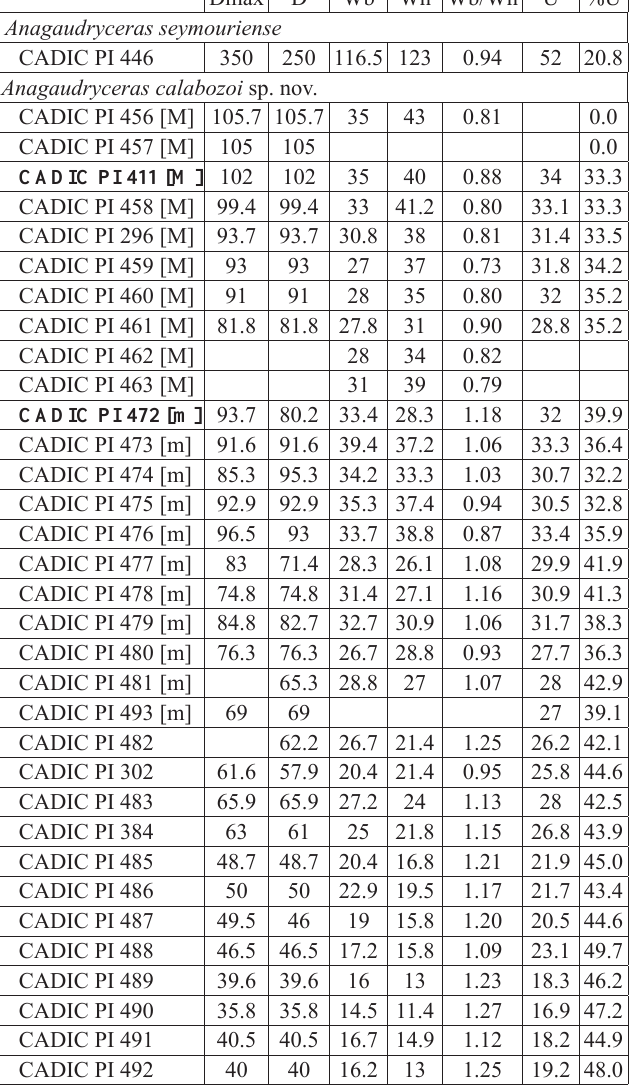
Table 4. Dimensions (in mm) of Anagaudryceras seymouriense and Anagaudryceras calabozoi sp. nov. Type material is indicated in bold. Abbreviations: D, diameter; Dmax, maximum diameter; U, umbilical diameter; %U, umbilical dia meter as % of D; Wb, whorl breadth at a given D; Wh, whorl height at a given